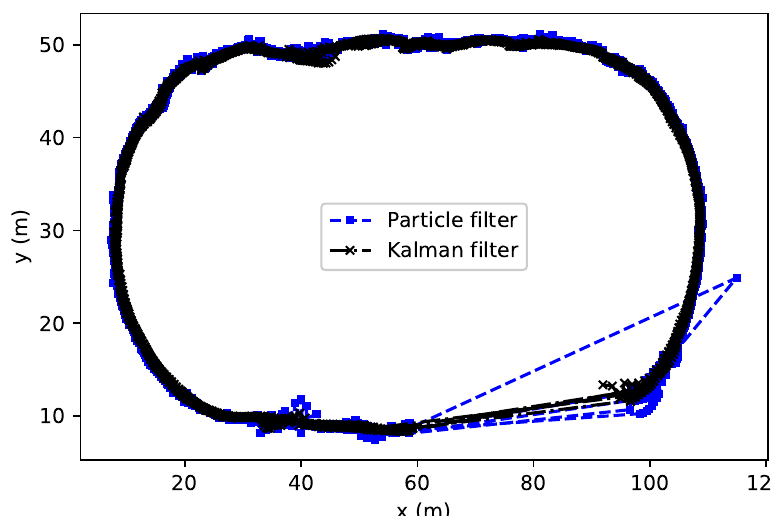
Figure 12. UWB tracking for indoor cycling with particle and Kalman filters.